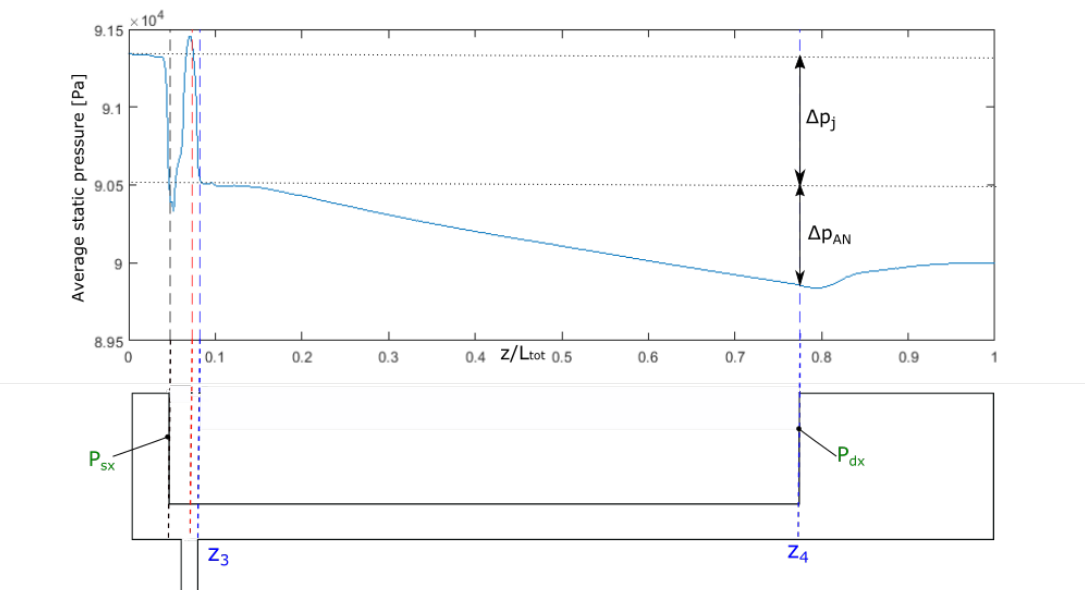
p ( z 3 ) is the pressure difference between the front chamber and the end where ∆ p j = p sx − of the jet region, and ∆ p AN is the pressure difference in the annular region.